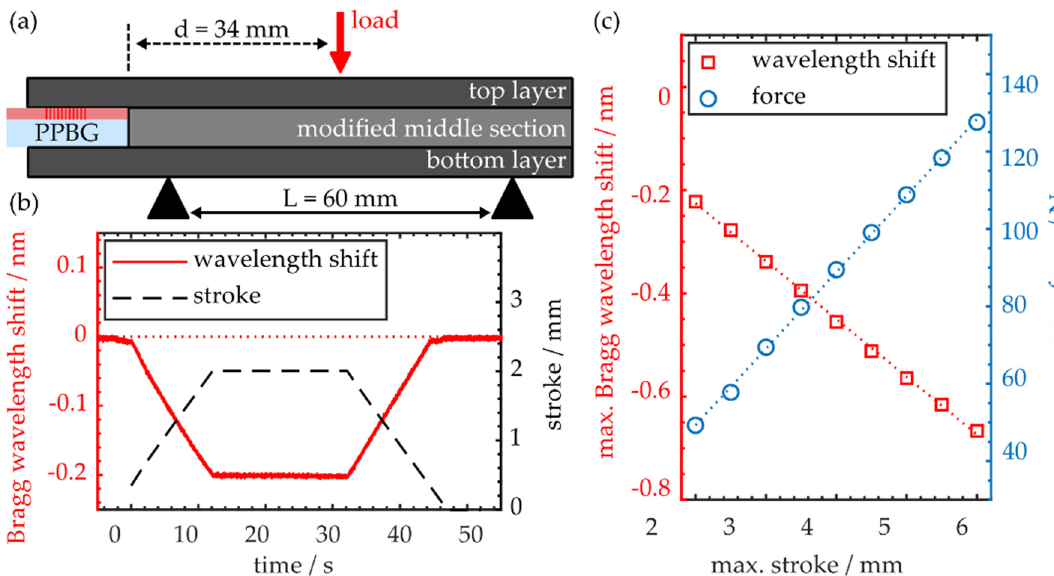
Figure 6. ( a ) Schematic of the employed experimental setup and sensor positioning within the specimen; ( b ) Time trace of workpiece deflection and sensor response during a three-point flexural cycle; ( c ) Maximum Bragg wavelength shift and respective force as a function of maximum stroke during multiple three-point flexural testing cycles.